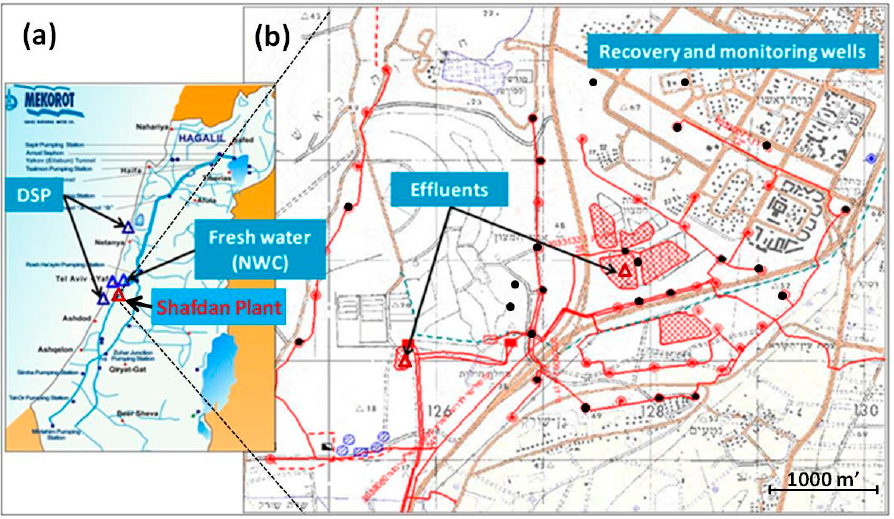
Figure 2. Experiment setup and the sampling program implemented in the study: ( a ) Schematic layout of the Israeli National Water Carrier with the locations of Hadera and Palmahim desalination plants (DSPs) and the Shafdan plant. Blue triangles represent the freshwater sampling points; ( b ) Enlarged map of the Shafdan area and the Soreq recharge basin. Red triangles represent effluents sampling points. Black dots represent recovery and observation wells that were sampled. Table 1. General description of the sub ‐ experiments conducted during the campaigns.